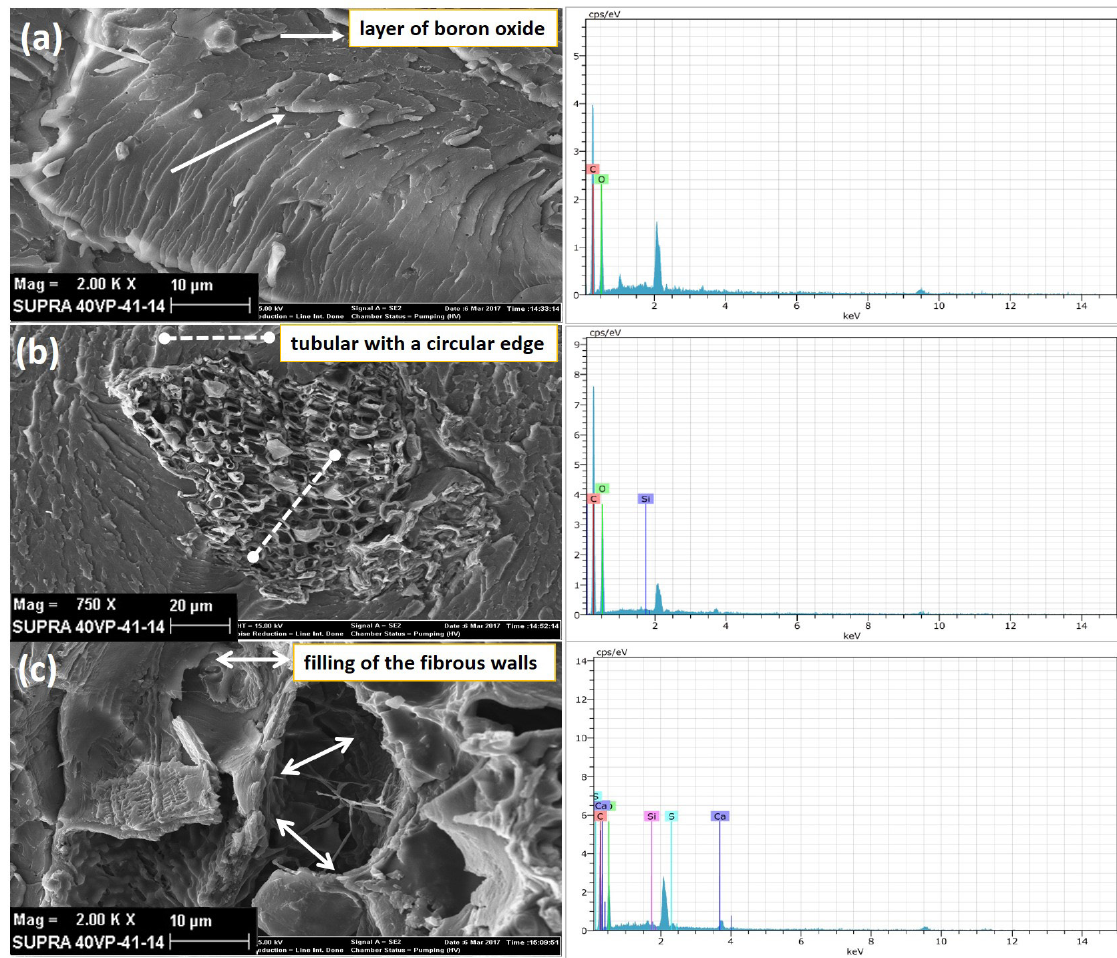
Figure 7: SEM images and EDX results of composite materials a) B1P b) PI1P c)